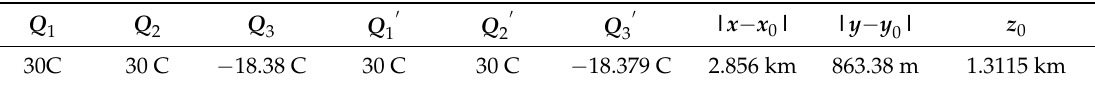
Table 1. Parameters of the three-layer charging model of thunderstorm